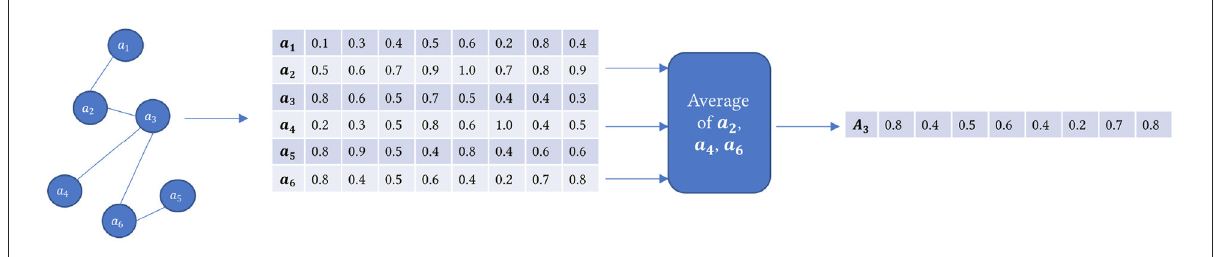
FIGURE5 How article embeddings are